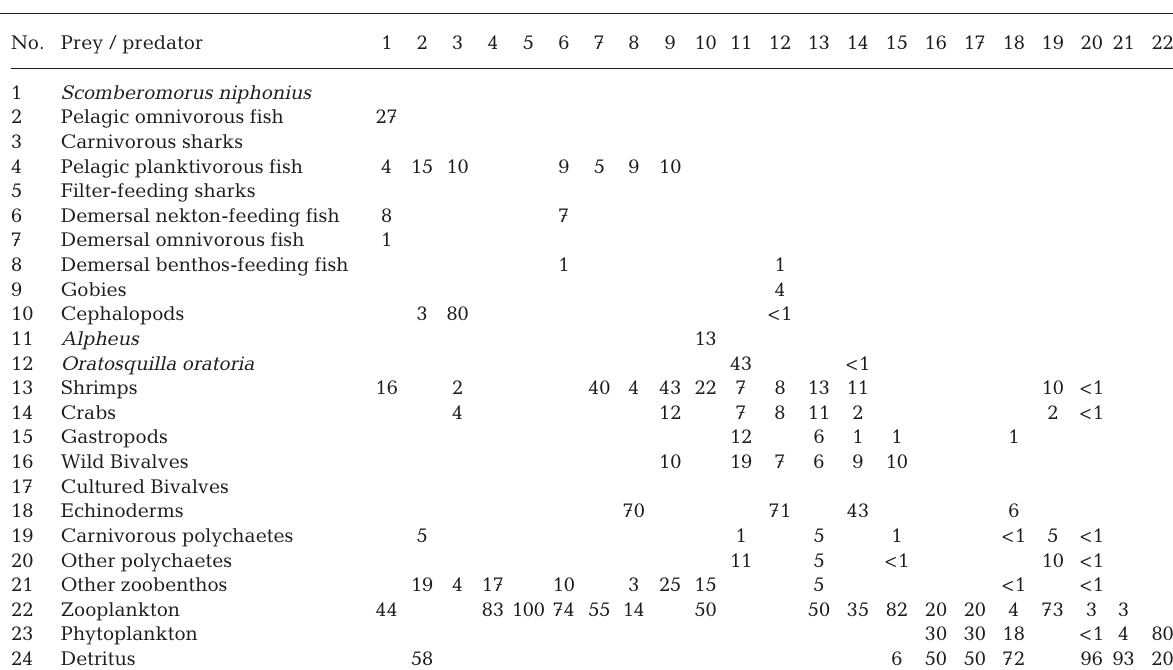
Table 2. Input diet matrix. The predators are represented by column and their prey by row. All diet matrix parameters repre- sent percentage (%) composition of diet. The diet compositions of each functional group (i.e. down each column) sum to